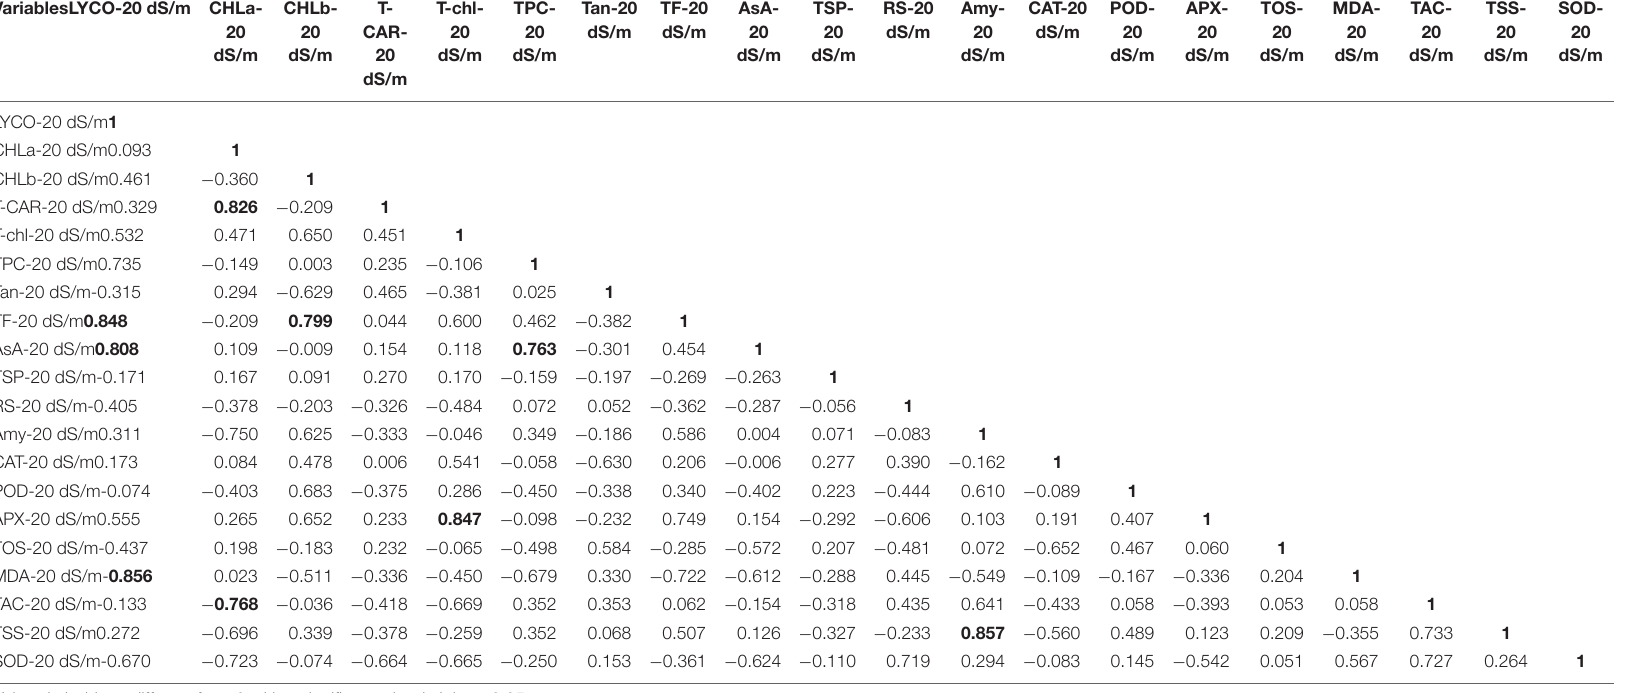
TABLE 17 | Correlation matrix for biochemical traits under 20 dS/m salt stress condition. VariablesLYCO-20 dS/m CHLa- 20